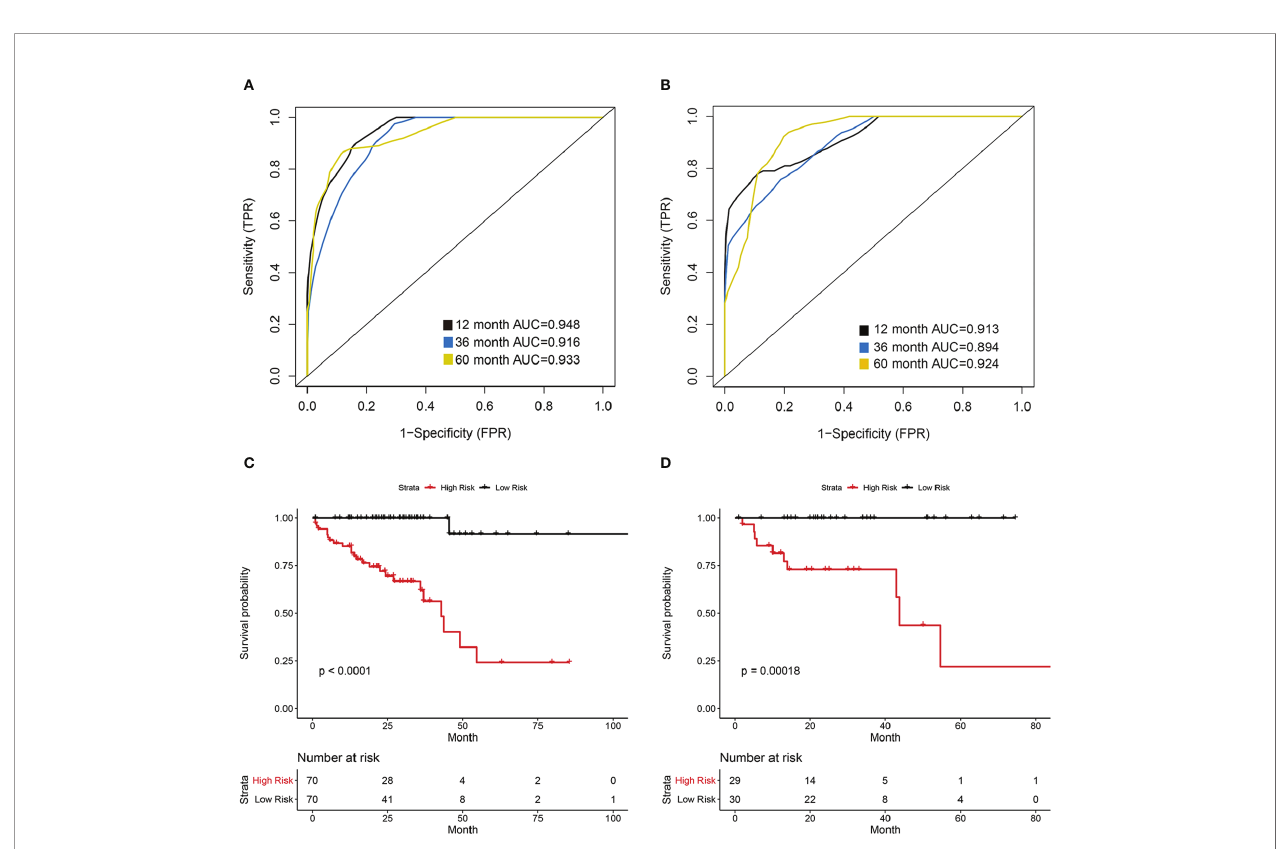
FIGURE 7 | Prognostic model of the histopathological-genomic prognosis factor (HGPF). (A) The training group 1-, 3-, and 5-year area under the curve (AUC) of a time-dependent receiver operating curve (ROC). (B) The test group 1-, 3-, and 5-year area under the curve (AUC) of a time-dependent receiver operating curve (ROC). (C) Survival analysis of the training cohort separated into high- and low-risk groups. (D) Survival analysis of the test cohort separated into high- and low-risk